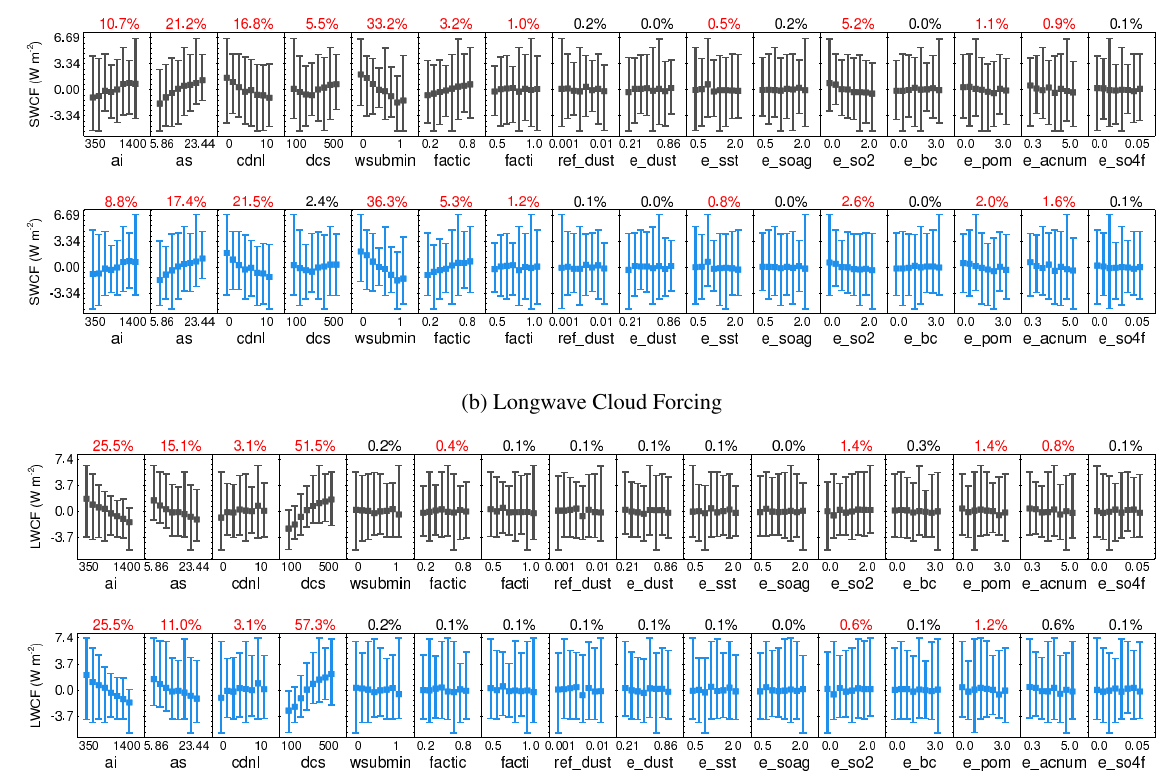
Figure 11. As in Fig. 10 but showing parametric sensitivities of the global mean (a) shortwave and (b) long-wave cloud forcing (unit: W m − 2 ).